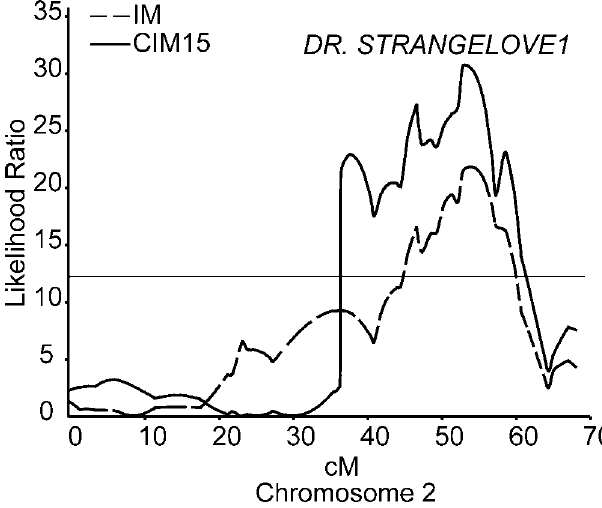
Figure 2. Identification and Localization of the Dr. Strangelove1 ( DSL1 ) QTL Affecting the Paternal Excess Interploidy Hybridization Barrier in Ler 3 Col-0 RIL Likelihood ratios (LRs; y -axis) for the presence of a QTL determined by interval mapping (IM; broken line) and composite interval mapping (CIM; solid line) affecting the frequency of plump seed in crosses of Col 3 Ler RIL to tetraploid Col. The position on A. thaliana chromosome 2 is presented, in centiMorgans, on the x -axis. The estimated p , 0.05 threshold at LR ¼ 12.6 (horizontal line) was determined by